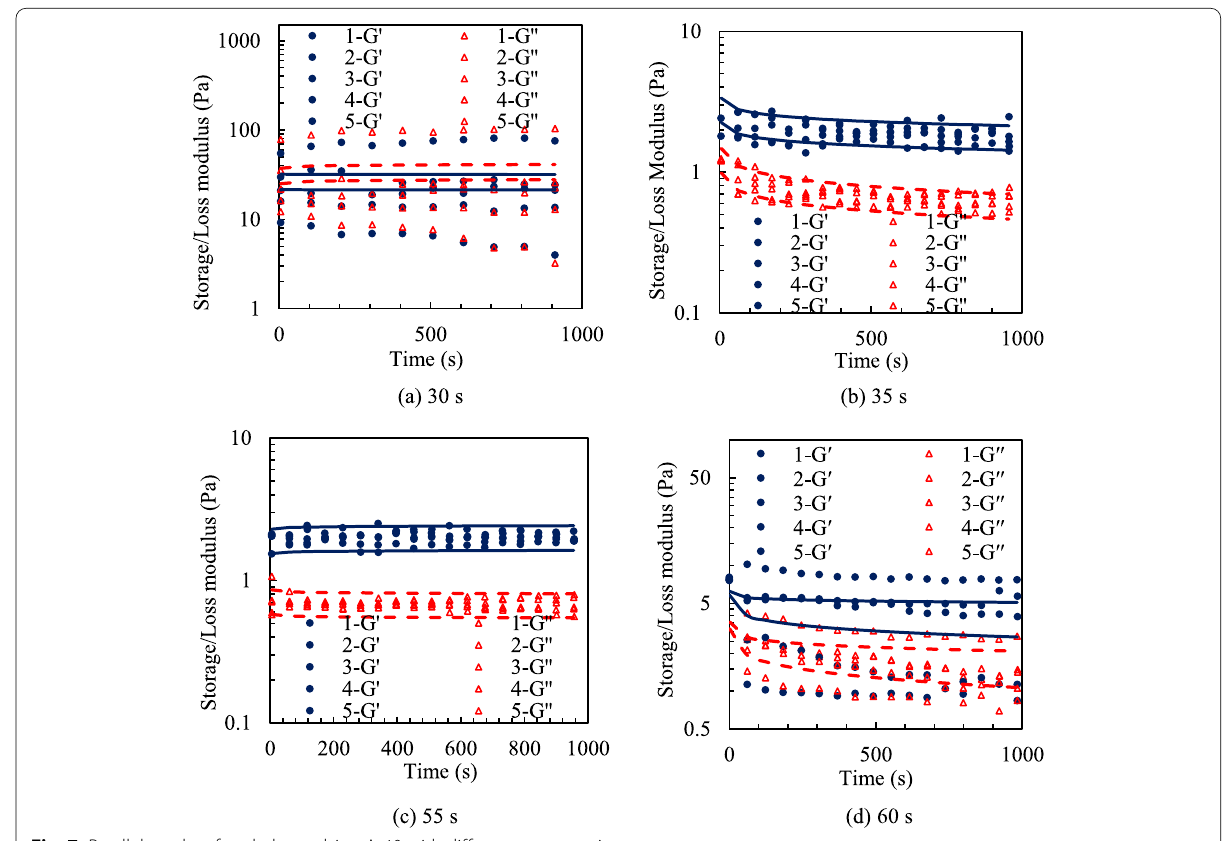
Fig. 7 Parallel results of asphalt emulsion A-40 with different recovery